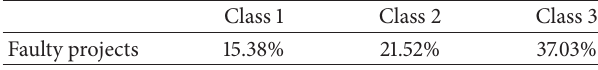
Table1:Contributionoftheeffortrelatedvariablesonthefirst(LD1) and second (LD2) discriminant functions.